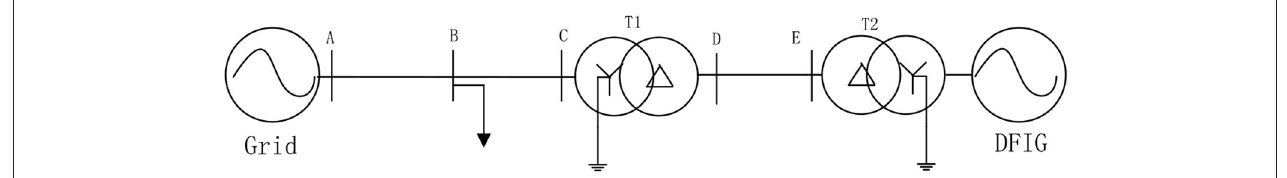
FIGURE 5 | The grid structure with DFIG wind